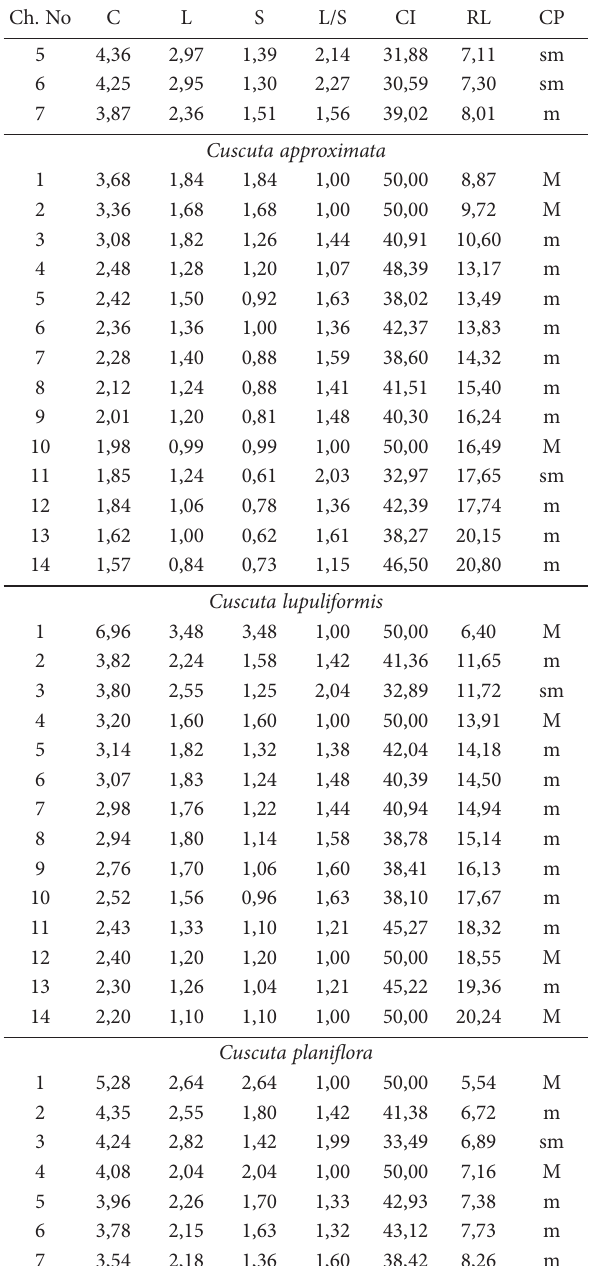
Chromosome arm ratios vary between 2.27-1 μm. Its centromere index ranges from 50.00-30.59 μm and rela- tive length is between 6.46 and 8.01 μm. The intra-chro- mosomal asymmetric index (A1) is 0.34, and the inter- chromosomal asymmetric index (A2) is 0.07 (Table 2, Figure 1). Cuscuta brevistyla : The chromosome number of